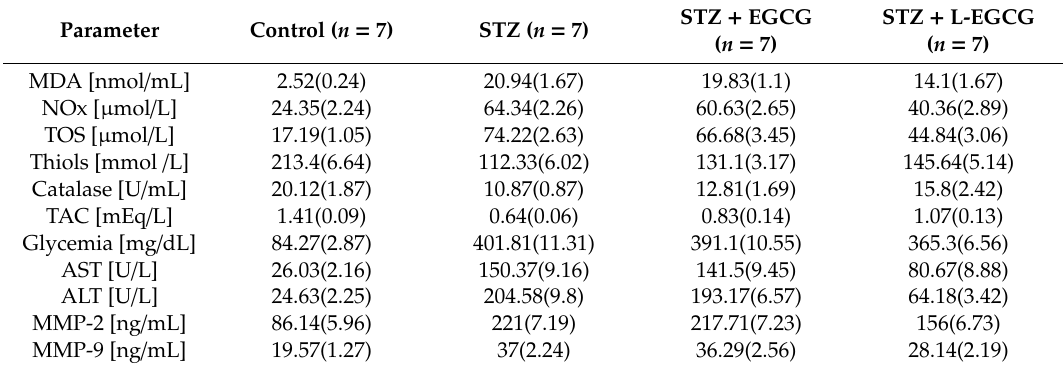
Table 1. Values of oxidative stress parameters, antioxidants levels, glycemia, hepatic enzymes, and matrix metalloproteinases in the four groups, expressed as mean and standard deviation.